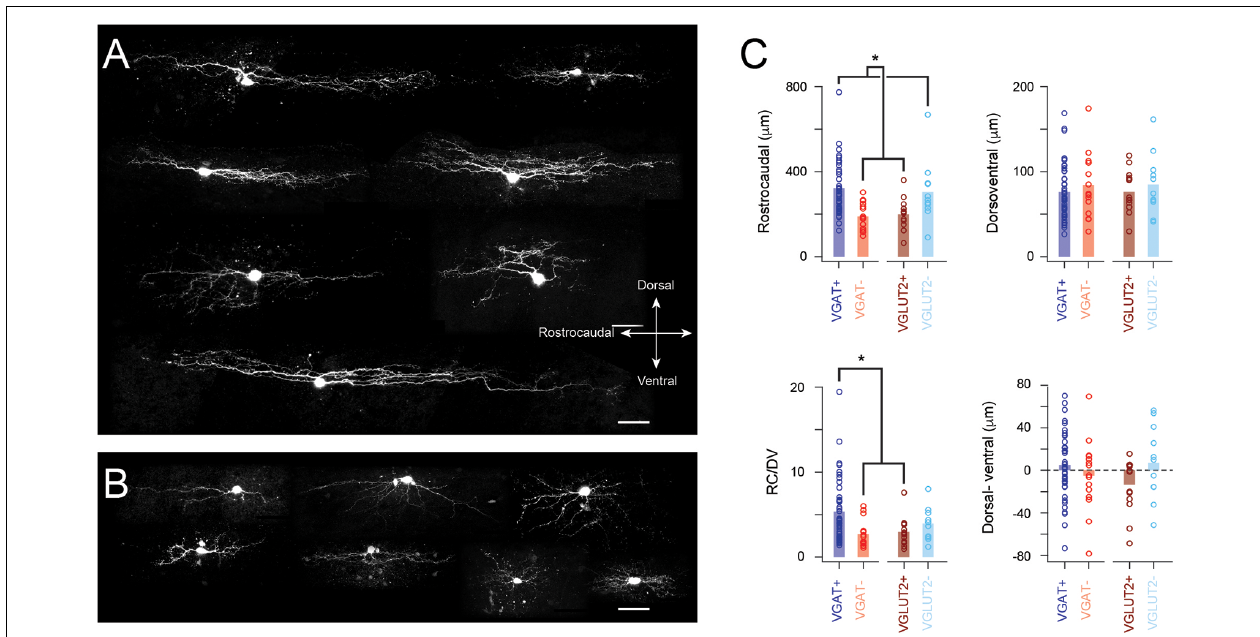
FIGURE 5 | Distinct morphological features in excitatory and inhibitory populations. (A) Images show example morphologies from inhibitory SDH neurons. Note, these neurons exhibit extensive rostrocaudally oriented dendritic arbors. (B) Images show example morphologies from excitatory SDH neurons. Morphology is more diverse in this neuron population and rostrocaudal dendritic expansion is limited. (C) Group-data plots comparing measures of dendritic extent and orientation for inhibitory and excitatory neurons. Consistent with examples above, inhibitory neurons (VGAT+ and VGLUT2 − ) exhibit larger dendritic fields in the rostrocaudal plane, whereas the dorsoventral field is similar in both populations. These measurements were used to calculate a dorsoventral dendritic field ratio (RV/DV). Note, this was the largest for VGAT+ neurons compared to the excitatory population. Finally, any preference for dorsal or ventral dendritic orientation was quantified by subtracting ventral expansion from dorsal expansion. There was no difference between inhibitory and excitatory populations. Despite this, a bias in the distribution of these data was observable in the excitatory (VGLUT2+ and VGAT − ) but not inhibitory (VGAT+ and VGLUT2 − ) datasets. This difference became significant when comparisons were limited to the VGAT+ and VGLUT2+ data (Scale bar: 50 µ m). * p <